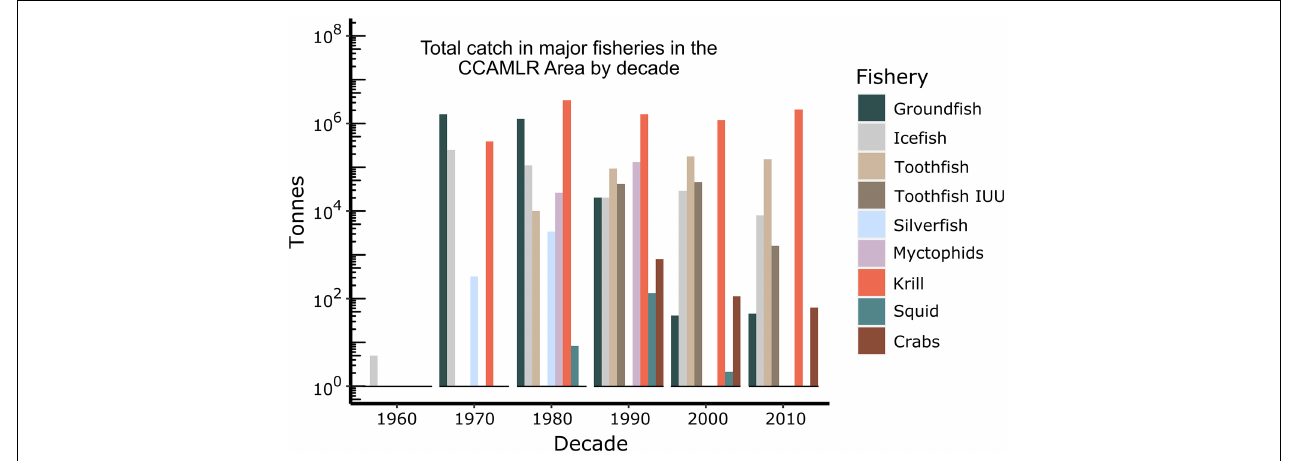
FIGURE 7 | Total catch (tonnes, all taxa) in each major fishery (legend) in the CCAMLR Area in each decade from the 1960s to the present. Data from the CCAMLR Statistical Bulletin 2019.